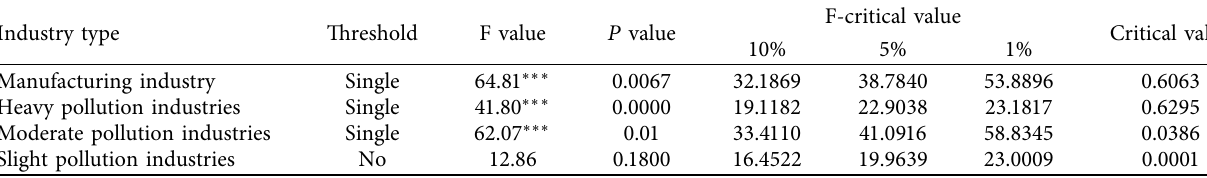
Table 6: Threshold effect test.